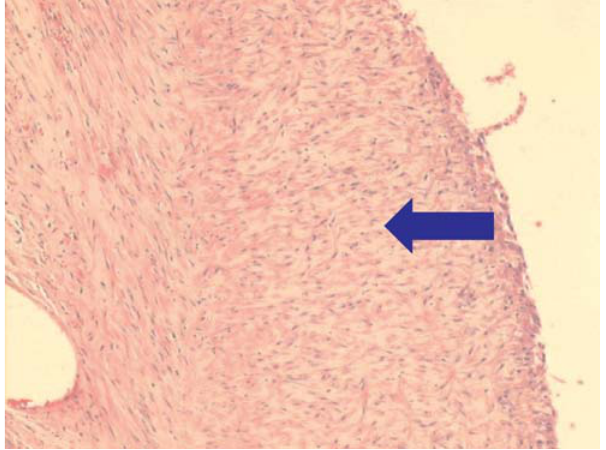
Figure 4 - Histological evaluation of aortas in Group C. The intima was thick, showing no endothelial deposits, a well-defined internal elastic lamina and a lack of inflammatory cells (blue arrow)